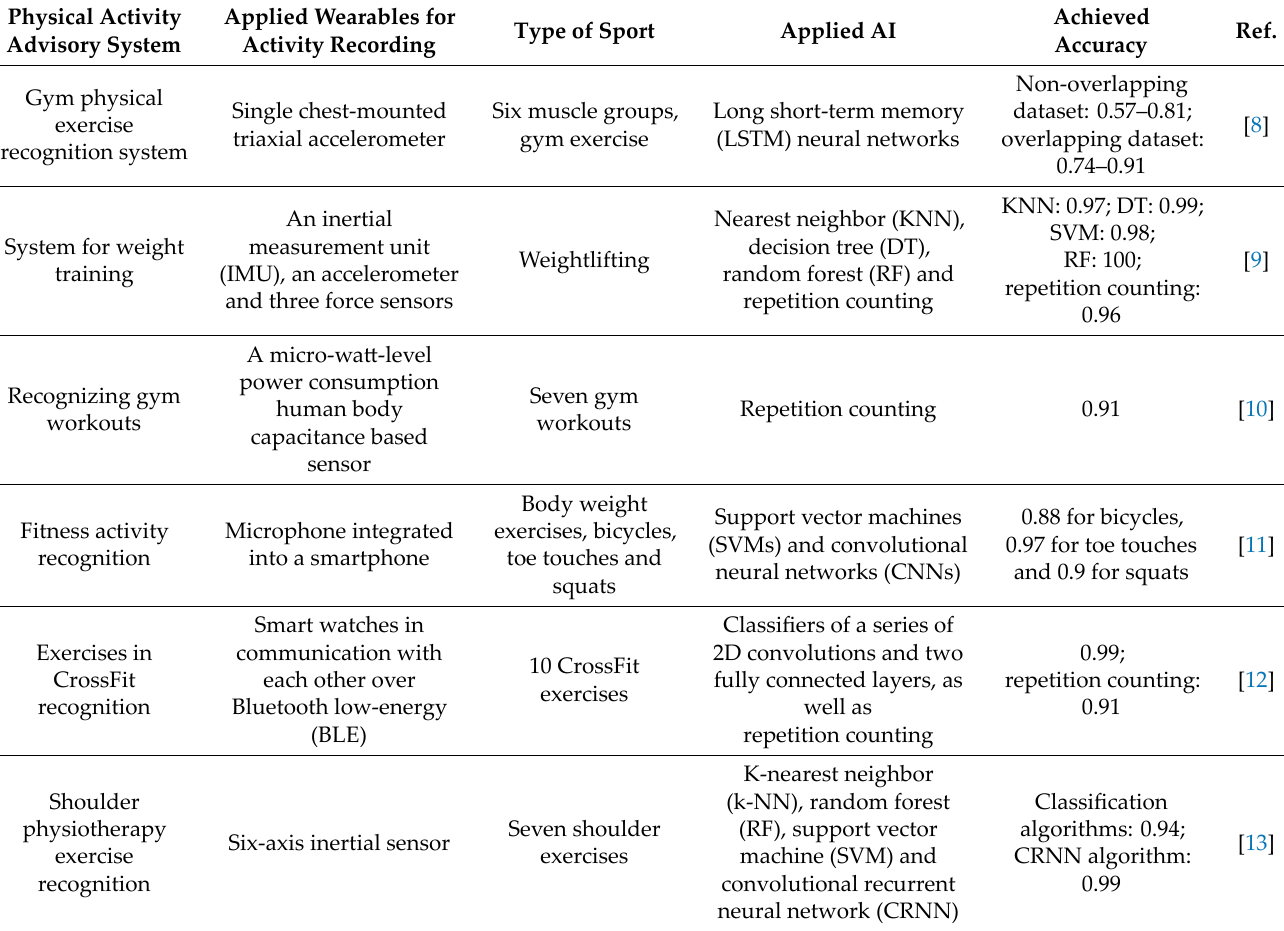
Table 1. A review of currently available solutions supporting the performance of sport